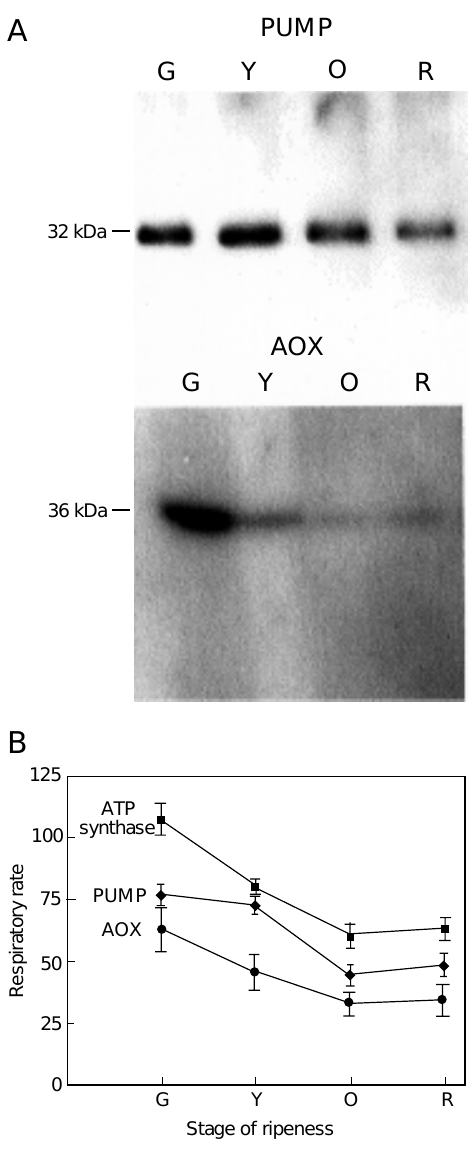
Figure 4 - Immunodetection of alternative oxidase (AOX) and plant uncoupling mitochondrial protein (PUMP) and analysis of respiratory activities during rip- ening. A , Immunoblot analysis of tomato mitochondrial proteins at different stages of ripeness (G, green; Y, yellow; O, orange, and R, red). Monoclonal antibod- ies against the Sauromatum guttatum AOX and polyclonal antibodies against the Solanum tuberosum PUMP were used (for details see 21). B , Respira- tory rate sustained by ATP syn- thase activity (squares), by LA- induced PUMP activity (loz- enges), and by AOX activity (circles) at different stages of ripeness (G, Y, O, R) are meas- ured as described in the text and in Ref.